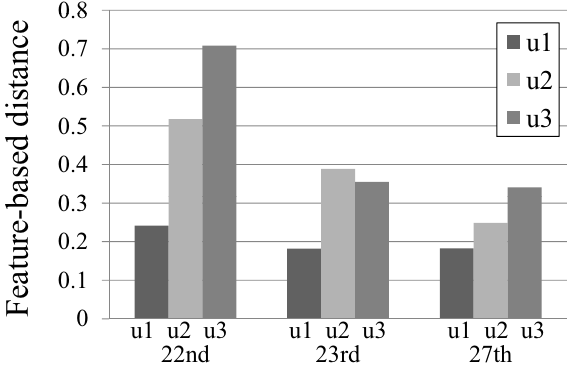
Figure 12. Feature-based distances between selected observation